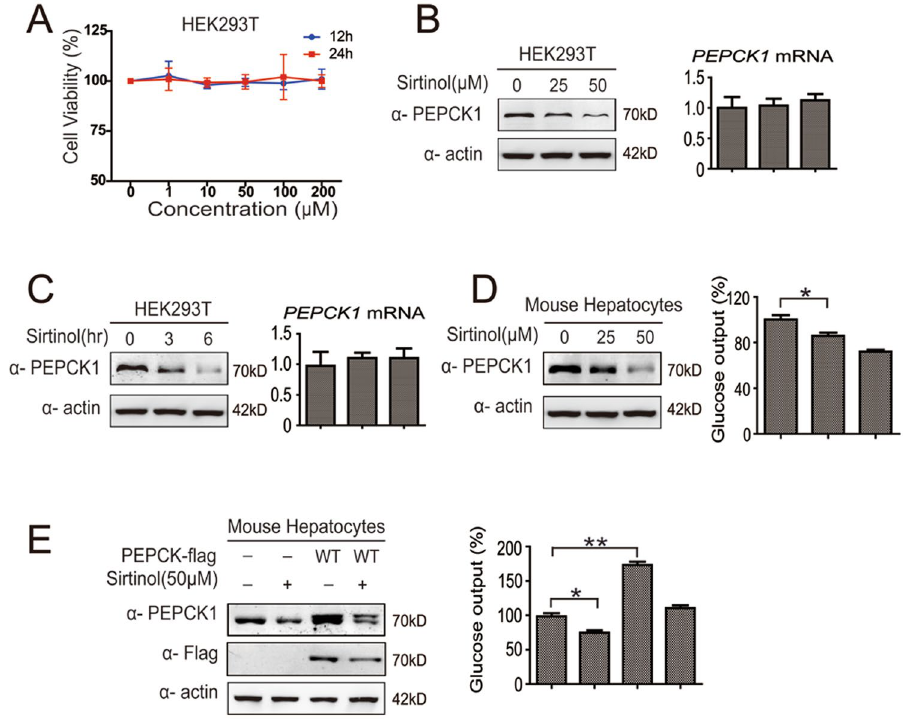
Figure 3. Sirtinol decreases protein levels of PEPCK1 and cell gluconeogenesis. ( A ) The cells were treated with indicated sirtinol (1–200 μ M) for 12 and 24 hours. Cells viability was detected by CCK-8 assay. ( B ) HEK293T cells were treated with indicated sirtinol for 4 hours. Cells were harvested and visualized by Western blotting and RT-PCR. ( C ) HEK293T cells were treated with 50 μ M sirtinol for indicated hours. Cells were harvested and visualized by Western blotting and RT-PCR. ( D ) Primary mice hepatocytes were treated with indicated sirtinol for 4 hours. Cells were then harvested and lysated, as well as visualized by Western blotting (left). Culture medium was collected and the glucose concentration was measured (right). ( E ) Primary mice hepatocytes were transfected with flag tagged PEPCK1 plasmid, as well as treated with 50 μ M sirtinol for 4 hours. Cells were harvested and visualized by Western blotting (left). Culture medium was collected and the glucose concentration was measured (right). The data are represented as the means ± SEM from three independent experiments. * P < 0.05; ** P < 0.01; NS, not